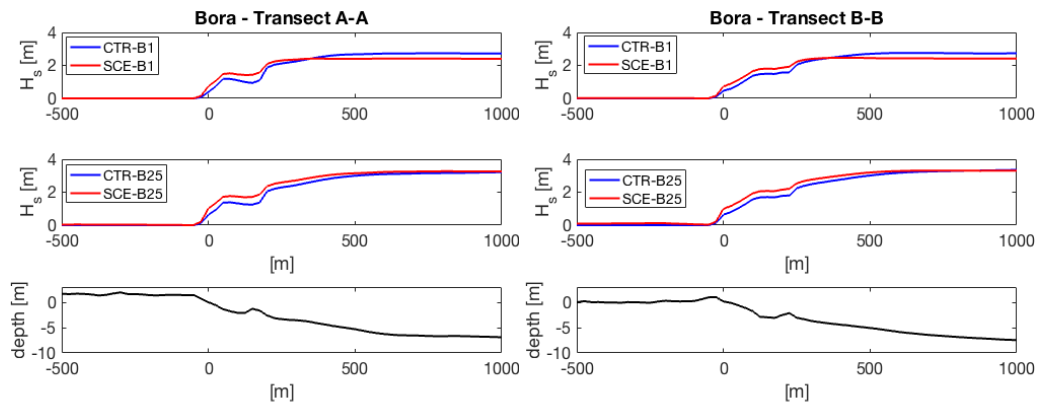
Figure 10. Bora events. Cross-shore distribution of the significant wave height H s as calculated by TOM along the transect A-A ( left panels ) and transect B-B ( right panels ).